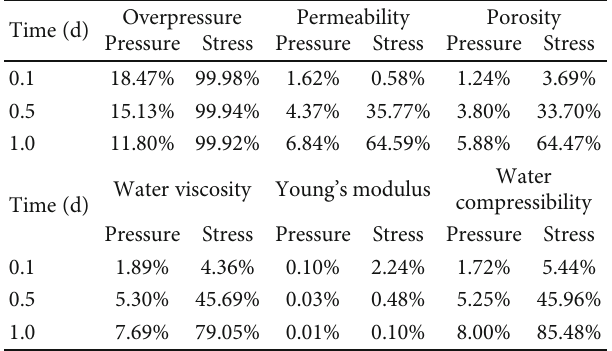
Figure 20: Cumulative water production at the wellbore during one day of shallow water fl ow for water compressibility sensitivity. Table 5: Relative impacts Δ θ / Δ ω of six sensitivity analysis Table 4: Relative impacts Δ θ / Δ ω of six sensitivity analysis parameters on cumulative water production in the wellbore during parameters on pressure and stress at three time steps. one day of shallow water fl